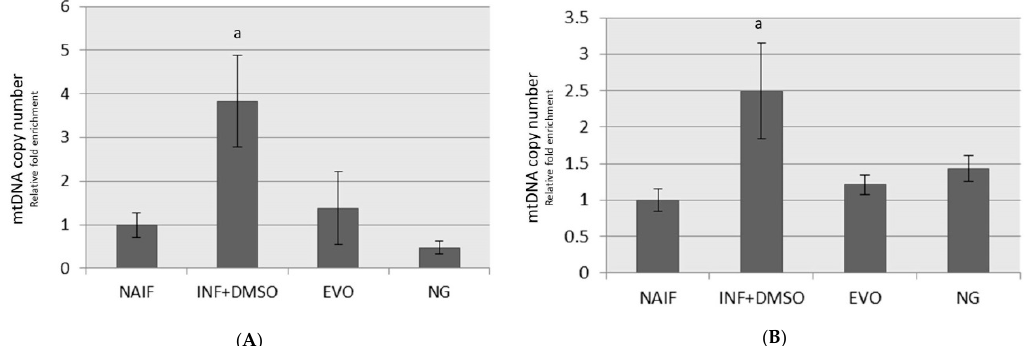
Figure 6. MtDNA copy number assessment after treatment under the two experimental conditions: ( A ) SET1; ( B ) SET2. a: p < 0.05.